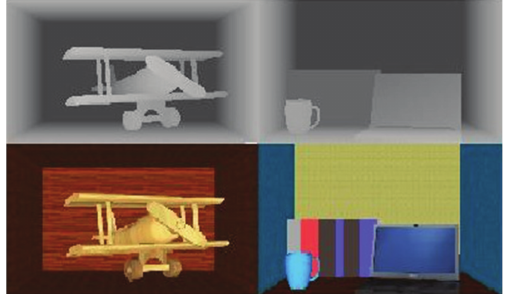
Figure 2: Two examples of the 3D scenes with their depth maps used in user preference study.